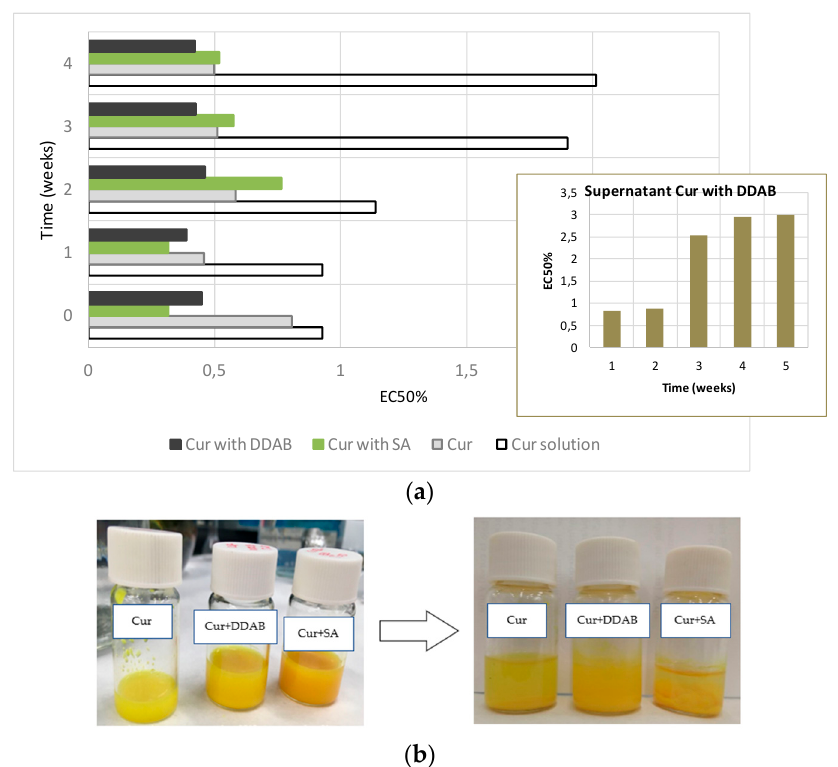
Figure 4. Antioxidant activity of Cur in liposome formulations with SA, DDAB, or without charged agent. ( a ) EC50% for the formulations, using Trolox as reference (EC50% 1 in red color). ( b ) Liposome samples of Cur and liposome samples of Cur containing SA or DDAB in the lipid bilayer, at time zero and after four weeks of storage.